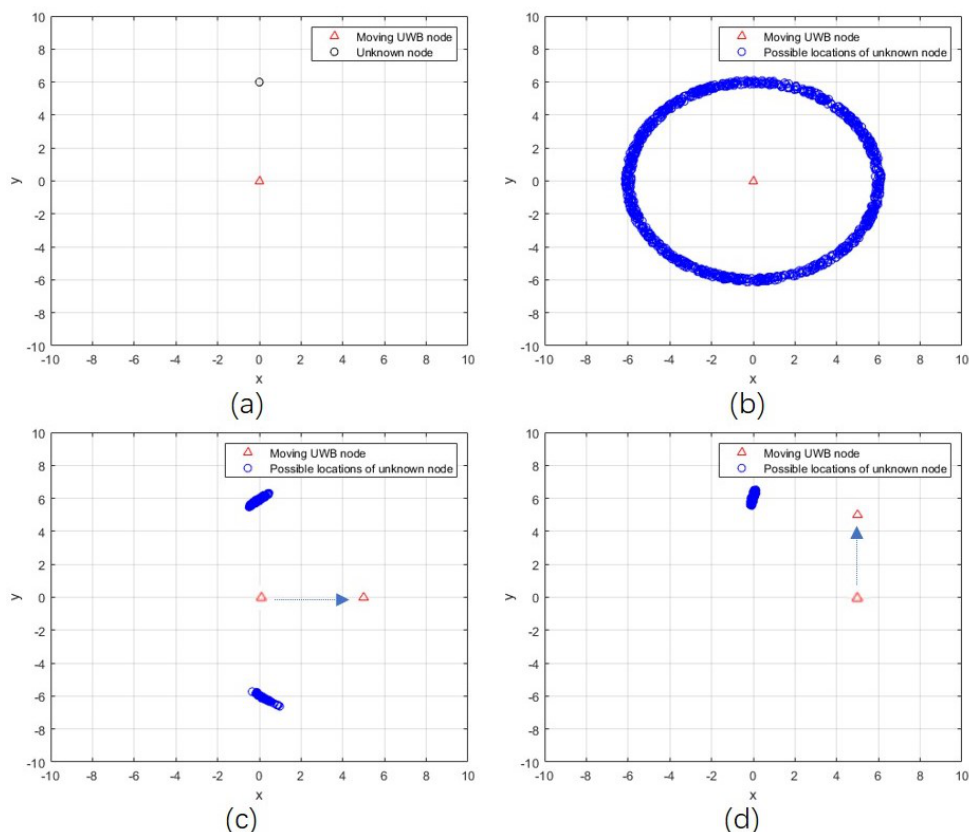
Figure 3. Possible positions of an uncalibrated node as the UAV moves. ( a ) The initial position of the UAV and uncalibrated node; ( b ) the possible positions of the uncalibrated nodes at the initial moment; ( c ) as the UAV moves along the x -axis direction, the uncertainty in the x -axis direction gradually decreases; ( d ) as the UAV moves along the y -axis direction, the uncertainty in the y -axis direction gradually